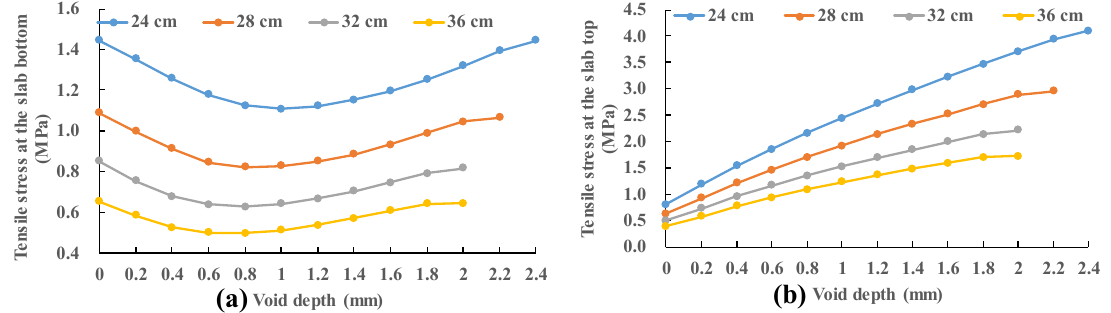
Figure 15. Tensile stress variation of 1.0 m void size with void depth: ( a ) stress at the slab bottom and ( b ) stress at the slab top.